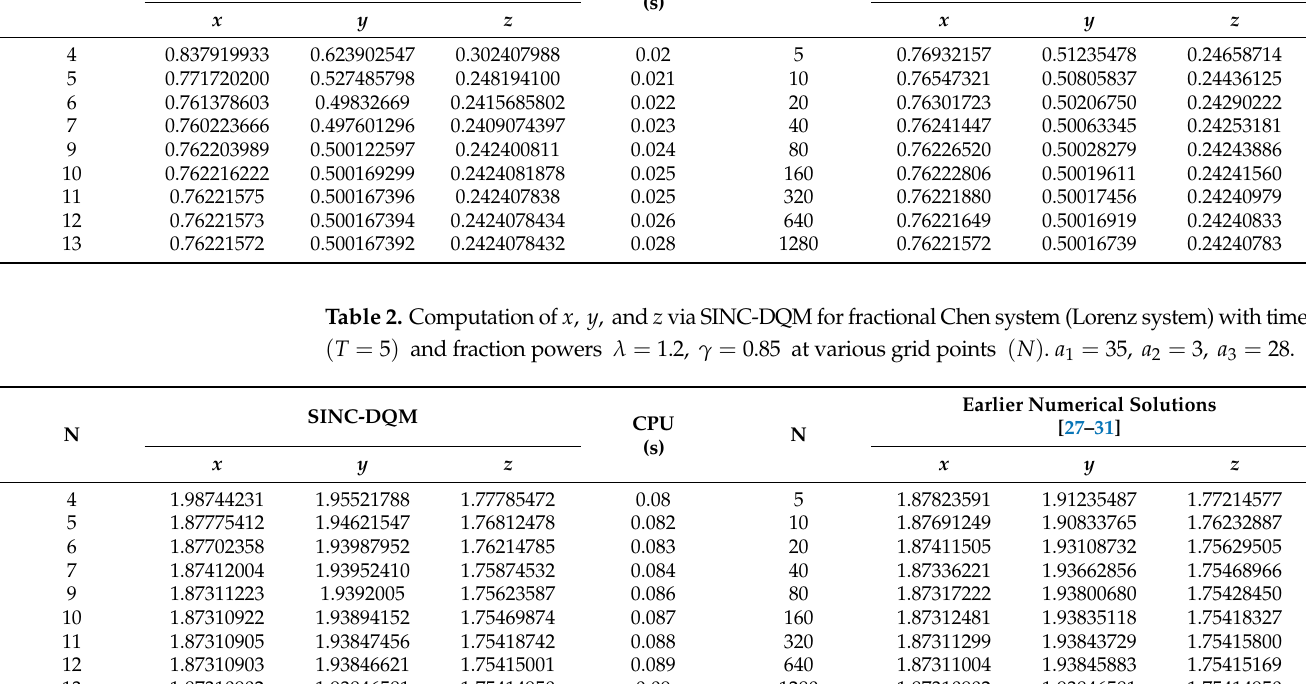
Table 2. Computation of 𝑥, 𝑦, and 𝑧 via SINC-DQM for fractional Chen system (Lorenz system) with time (cid:4666)𝑇 = 5(cid:4667) and fraction powers 𝜆 = 1.2, 𝛾 = 0.85 at various grid points (cid:4666)𝑁(cid:4667) . 𝑎 (cid:2869) = 35, 𝑎 (cid:2870) = 3, 𝑎 (cid:2871) = 28 .